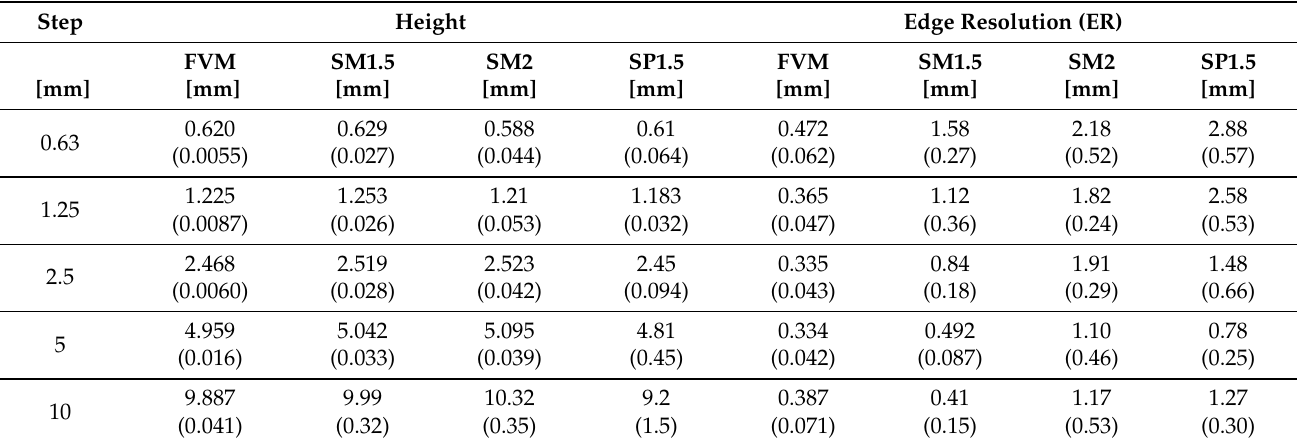
Table 3. Parameters from the step-height artifact measurements using FVM and SfM. SfM was conducted for marked pattern artifact at 1.5 m (SM1.5) and 2.0 m (SM2) and for artifact with projected light patterns at 1.5 m (SP1.5). Listed are mean height and ER values for each step. The standard deviations are shown in parentheses.